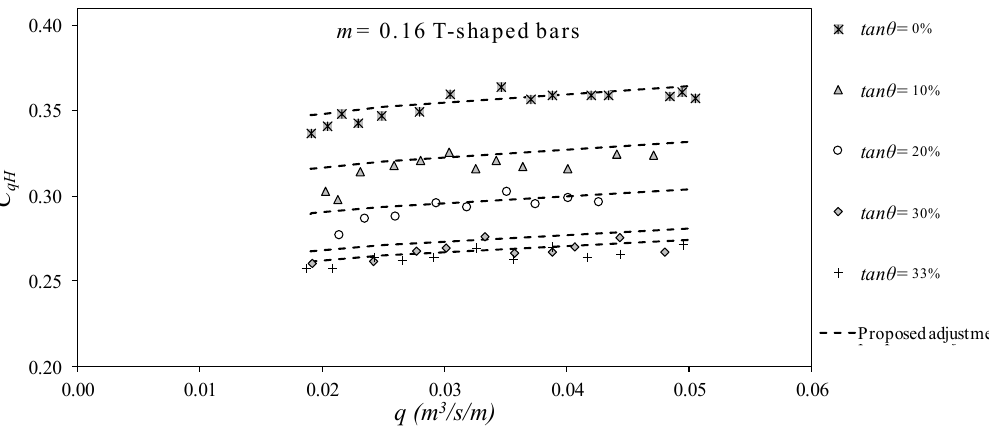
Figure 23. Mean discharge coefficient C qH as a function of the incoming flow q , for T-shaped flat bars with void ratio m = 0.16.